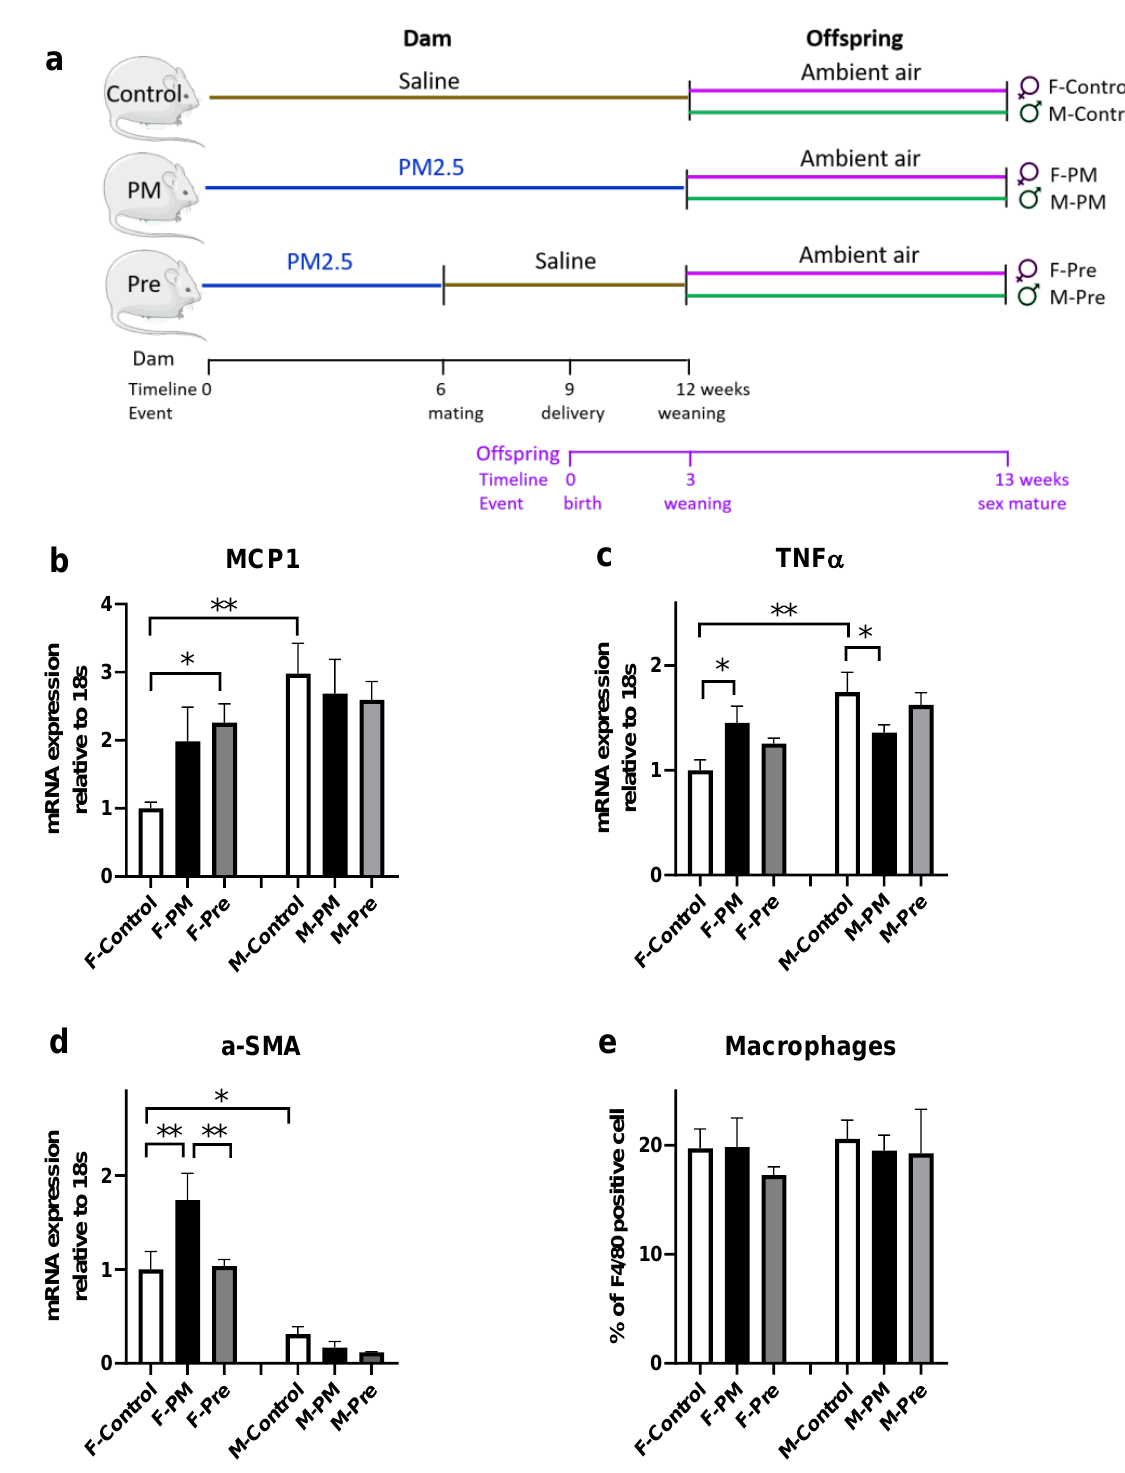
Figure 1. Schematic of the Experimental Model and Characterisation of inflammatory Markers in Female and Male Offspring. Experimental design ( a ). mRNA levels of MCP1: monocyte chemoat- tractant protein 1 ( b ), TNF α : tumour necrosis factor α ( c ), and α -SMA: α -smooth muscle actin 2 ( d ), as well as F4/80 positive macrophages ( e ). Results are expressed as mean ± SEM, n = 6 ( a – c ), n = 3 ( d ), n = 3–4 ( e ). * p < 0.05, ). ** p < 0.01. F: female; M: male; PM: offspring from dams continuously exposed to PM2.5; Pre: offspring from dams exposed to PM2.5 before conception only.